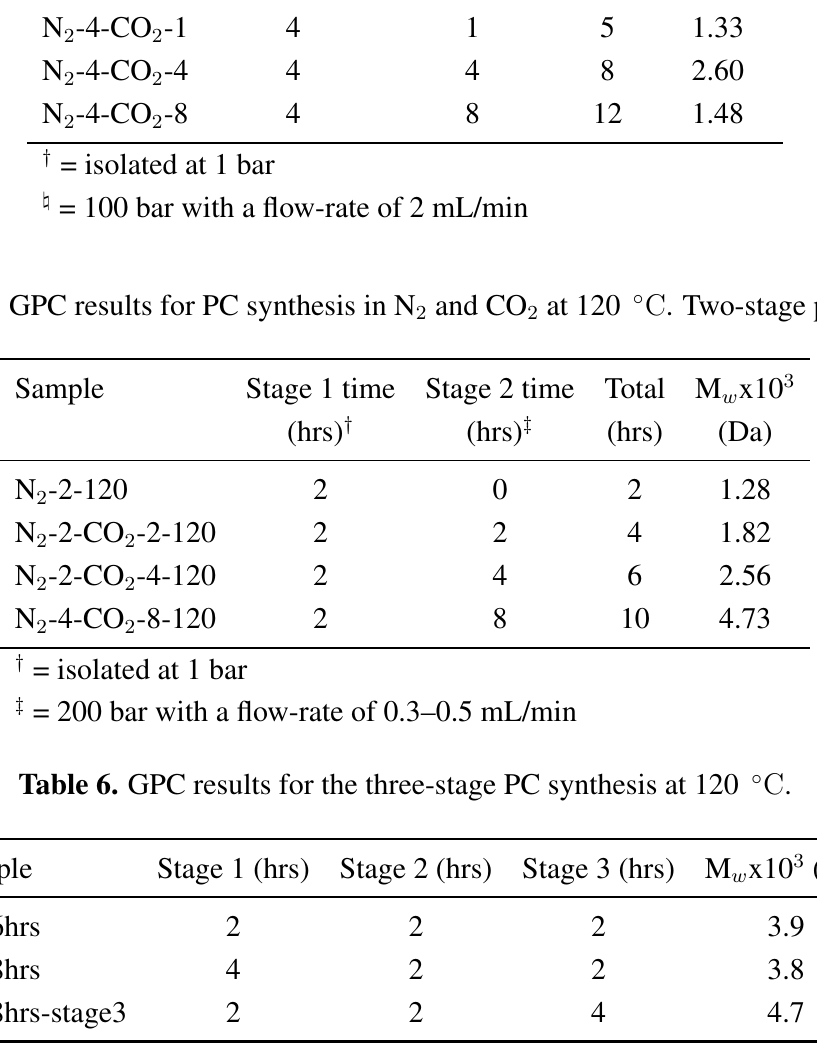
Table 5. GPC results for PC synthesis in N